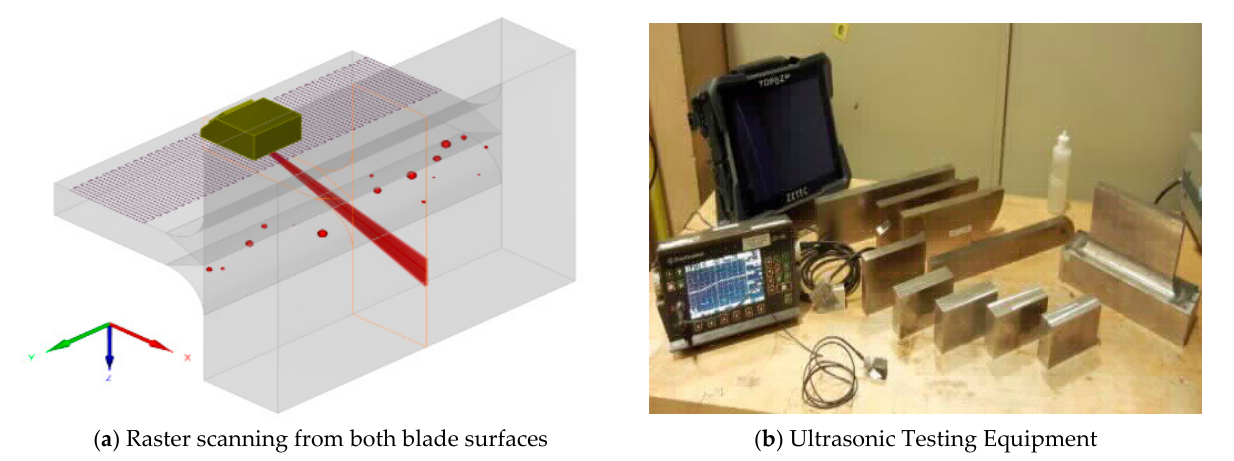
Figure 2. Simulation and experimental Setup